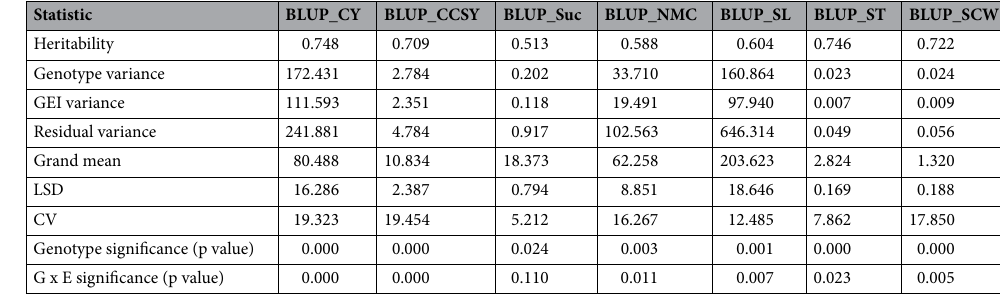
Table 1. Estimates of genetic parameters from multi environment BLUPs for cane yield, CCS yield and components under tillering phase drought stress at ten test drought environments. BLUP best linear unbiased prediction, CY cane yield (t/ha), CCSY commercial cane sugar yield (t/ha), Suc sucrose percent at 12th month, SL stalk length (cm), ST stalk thickness (cm), SCW single cane weight (kg), NMC number of millable canes, LSD least square difference, CV coefficient of variation.